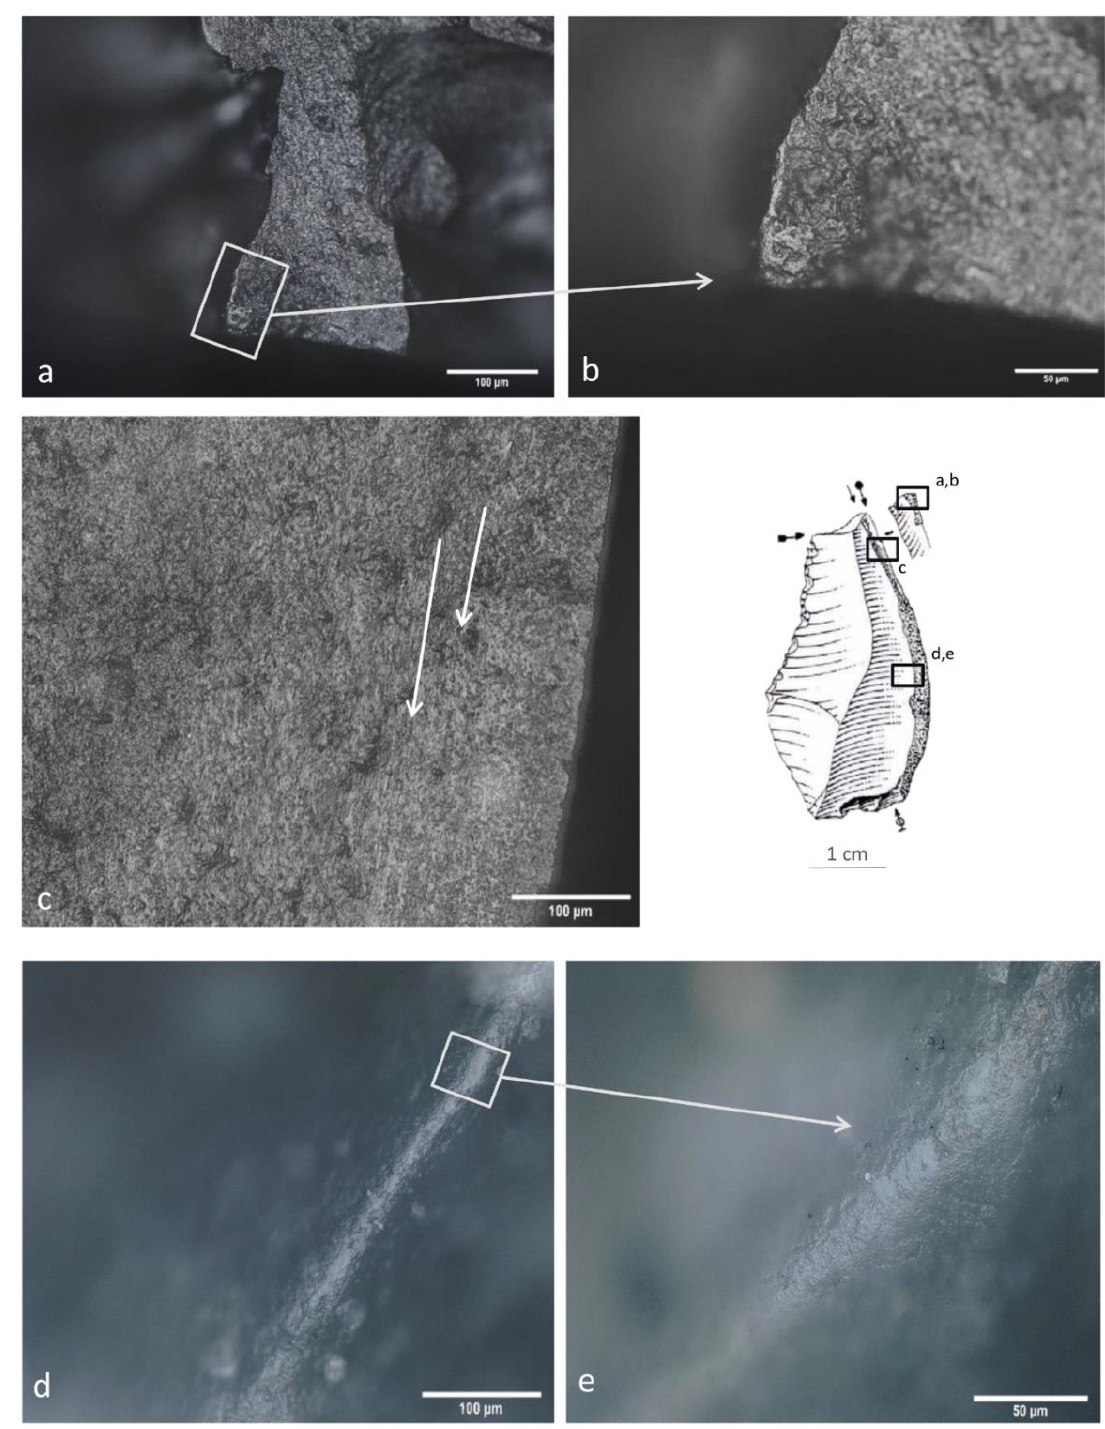
Figure 7. Burin LB01_4 interpreted as having been used on hard animal material; with a)+b) slight edge and tip rounding associated with a bright polish restricted to the prominent zone of the tip (100x and 200x); c) detail of the burin-facet with bright use polish, multiple use-related striations oriented parallel to the edge (100x); d)+e) details of the bright spot observed on the protruding part of the dorsal mesial ridge of the burin (100x and 200x) interpreted as a potential indication for